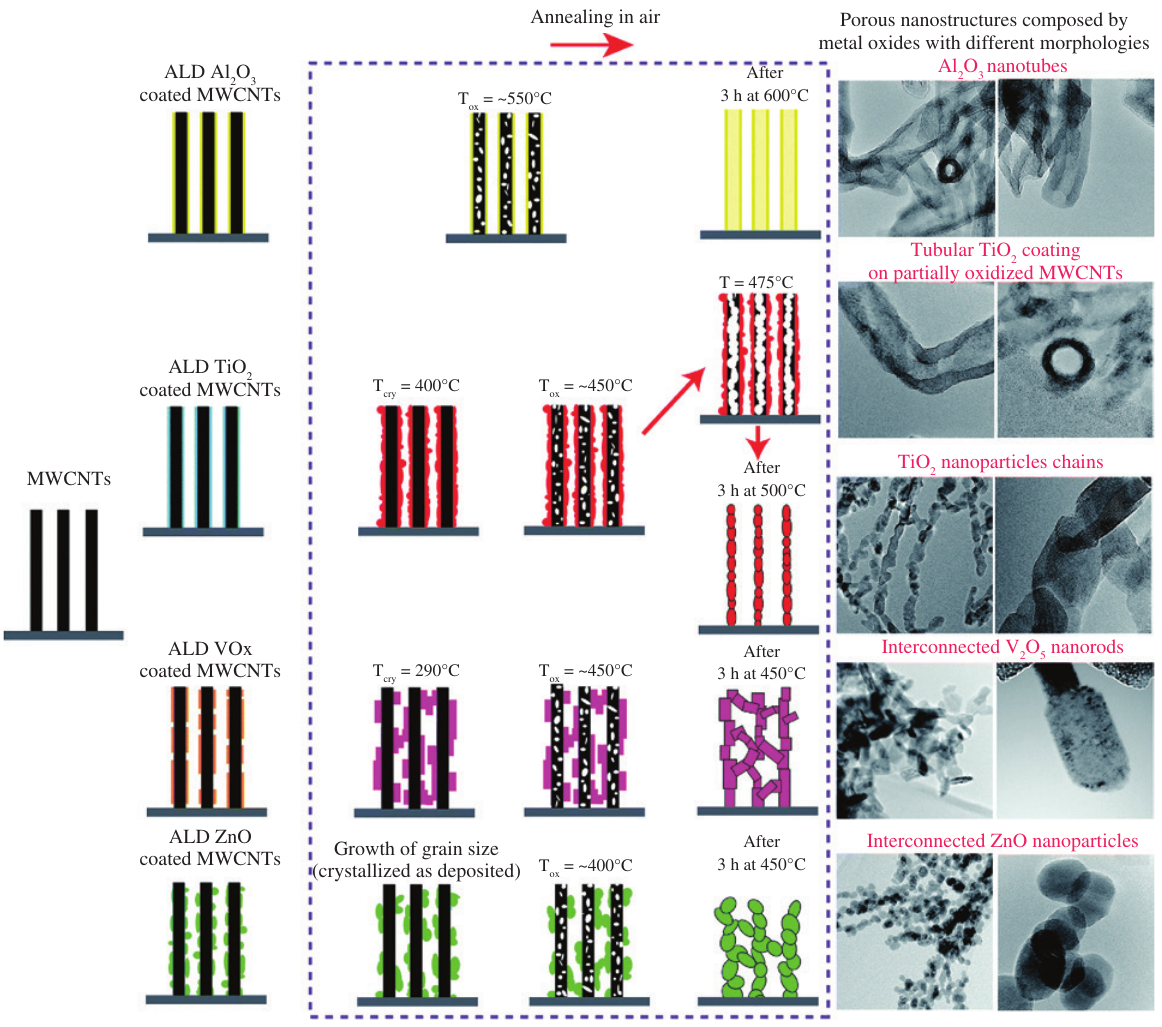
Figure 7: Schematic demonstration of the formation of porous metal oxide nanostructures by ALD on MWCNTs followed by calcination. Reprinted with permission from Ref. [45]. Copyright 2014 Royal Society of